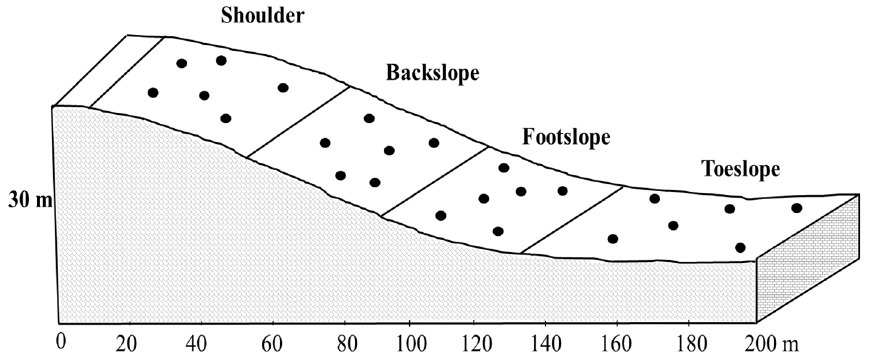
Figure 2. Three-dimensional pattern of sampling scheme in the study area in different hillslope po-